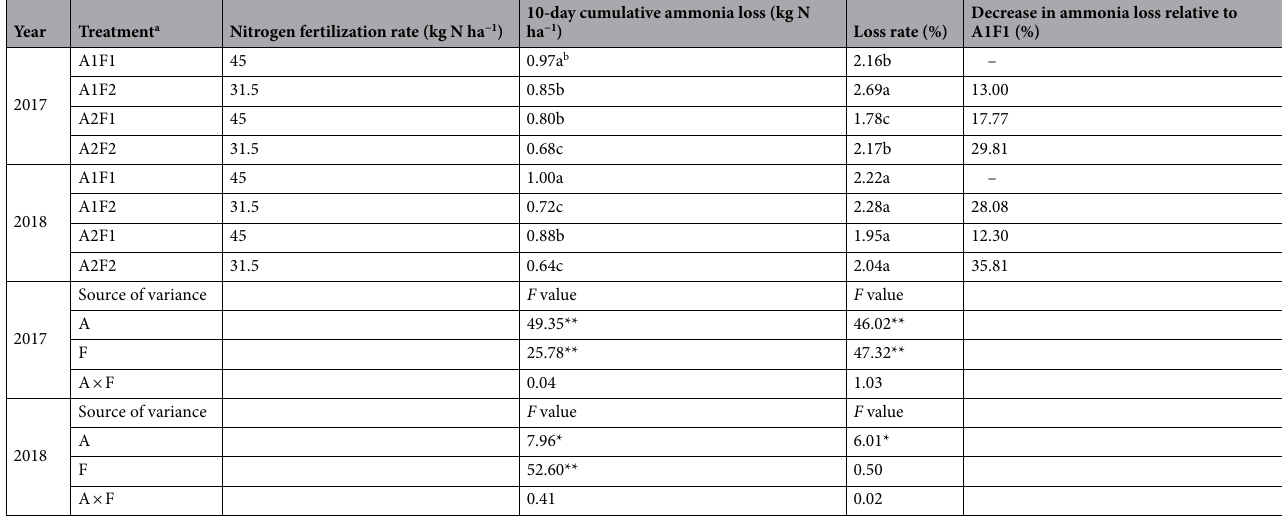
Table 6. Cumulative ammonia volatilization and its proportion of nitrogen fertilization rate under different treatments of summer maize at the seven-leaf stage in 2017 and 2018. a A and F represent dripline spacing and fertilization rate, respectively, as shown in Fig. 2 and Table 2. b Values within a column followed by different letters are significantly different at the 0.05 probability level; * and ** show significant difference at the 0.05 and 0.01 probability levels, respectively.